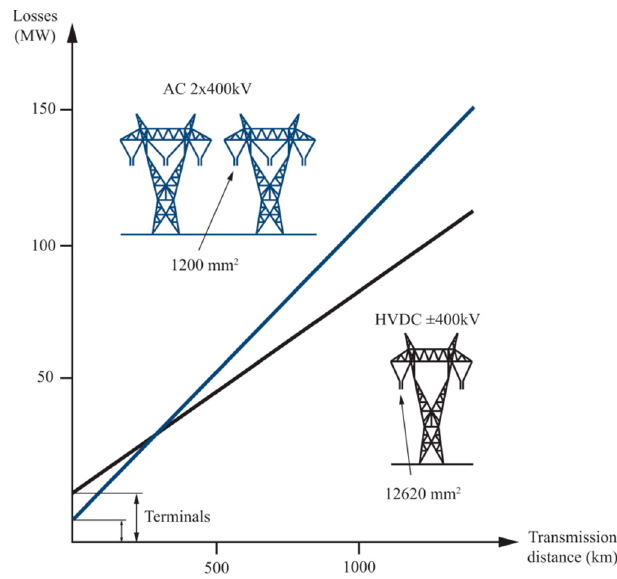
Figure 4. Power loss comparison between AC and DC lines.